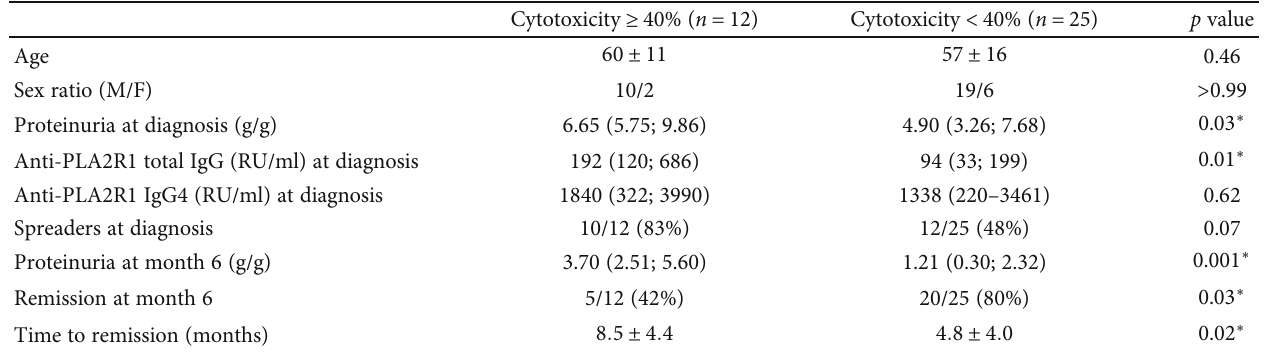
Table 2: Factors associated with cytotoxicity ≥ 40 % ( n = 37 patients treated with rituximab).